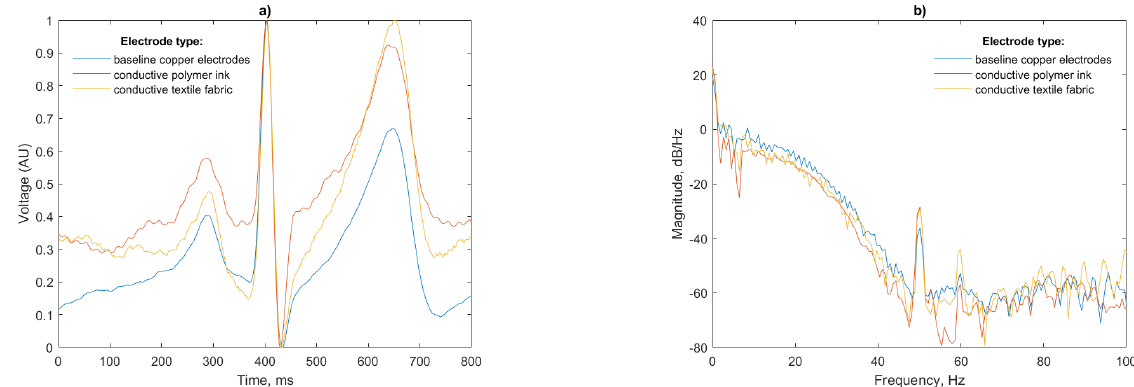
Figure 14. ( a ) Single beat waveform and ( b ) PSD of a human ECG for each electrode configuration.